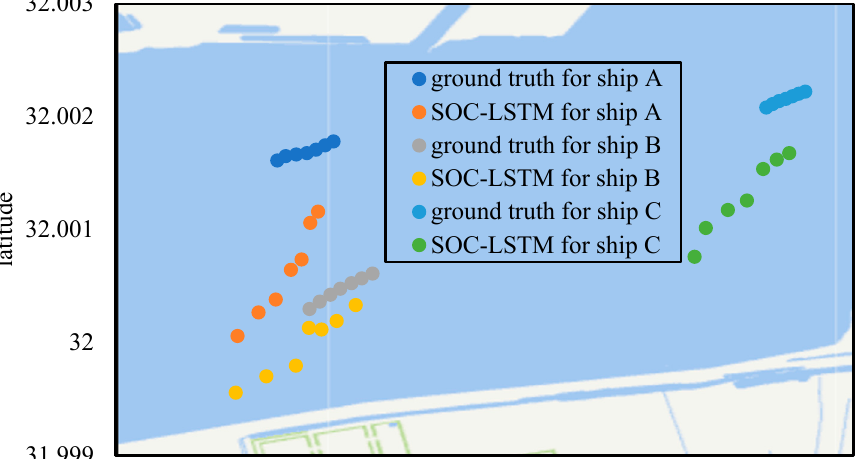
Figure 5. SOC-LSTM model prediction performance for different ships.